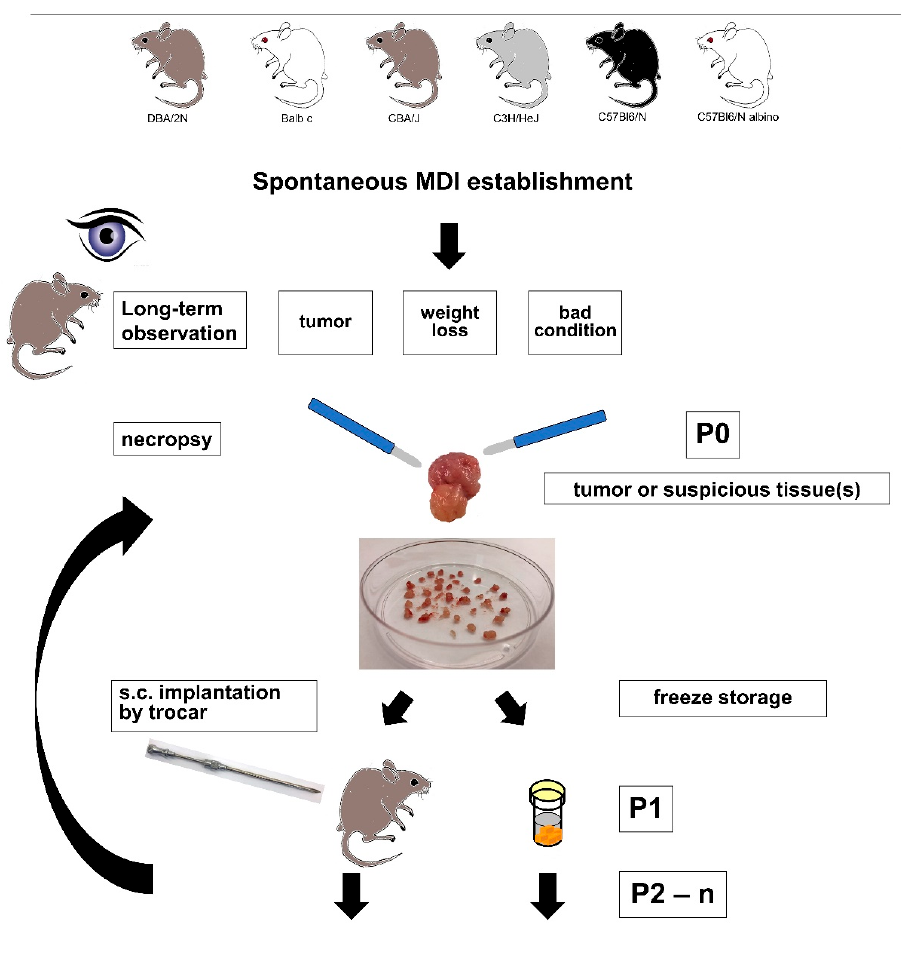
Figure 1. Schematic schedule of spontaneous mouse-derived isografts (sMDI) detection, selection, and establishment. The figure schematically shows the included mouse strains as well as the termination criteria and further handling of the tumor or other suspicious tissue samples. (s.c. = subcutaneous implantation).